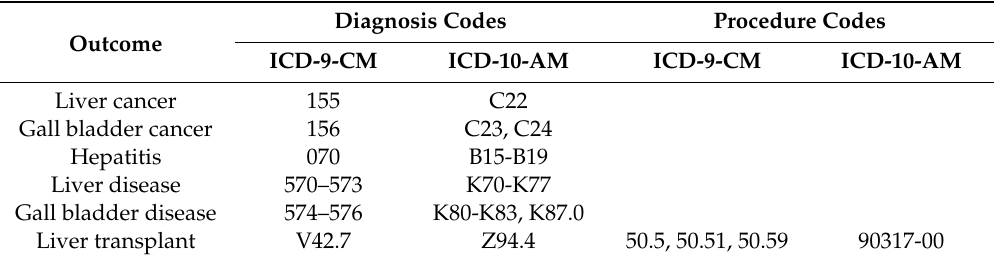
Table 1. International Classification of Disease (ICD)-9 Clinical Modification (CM) and ICD-10 Australian Modification (AM) codes used to identify hepatobiliary disease outcomes in the Hospital Morbidity Data